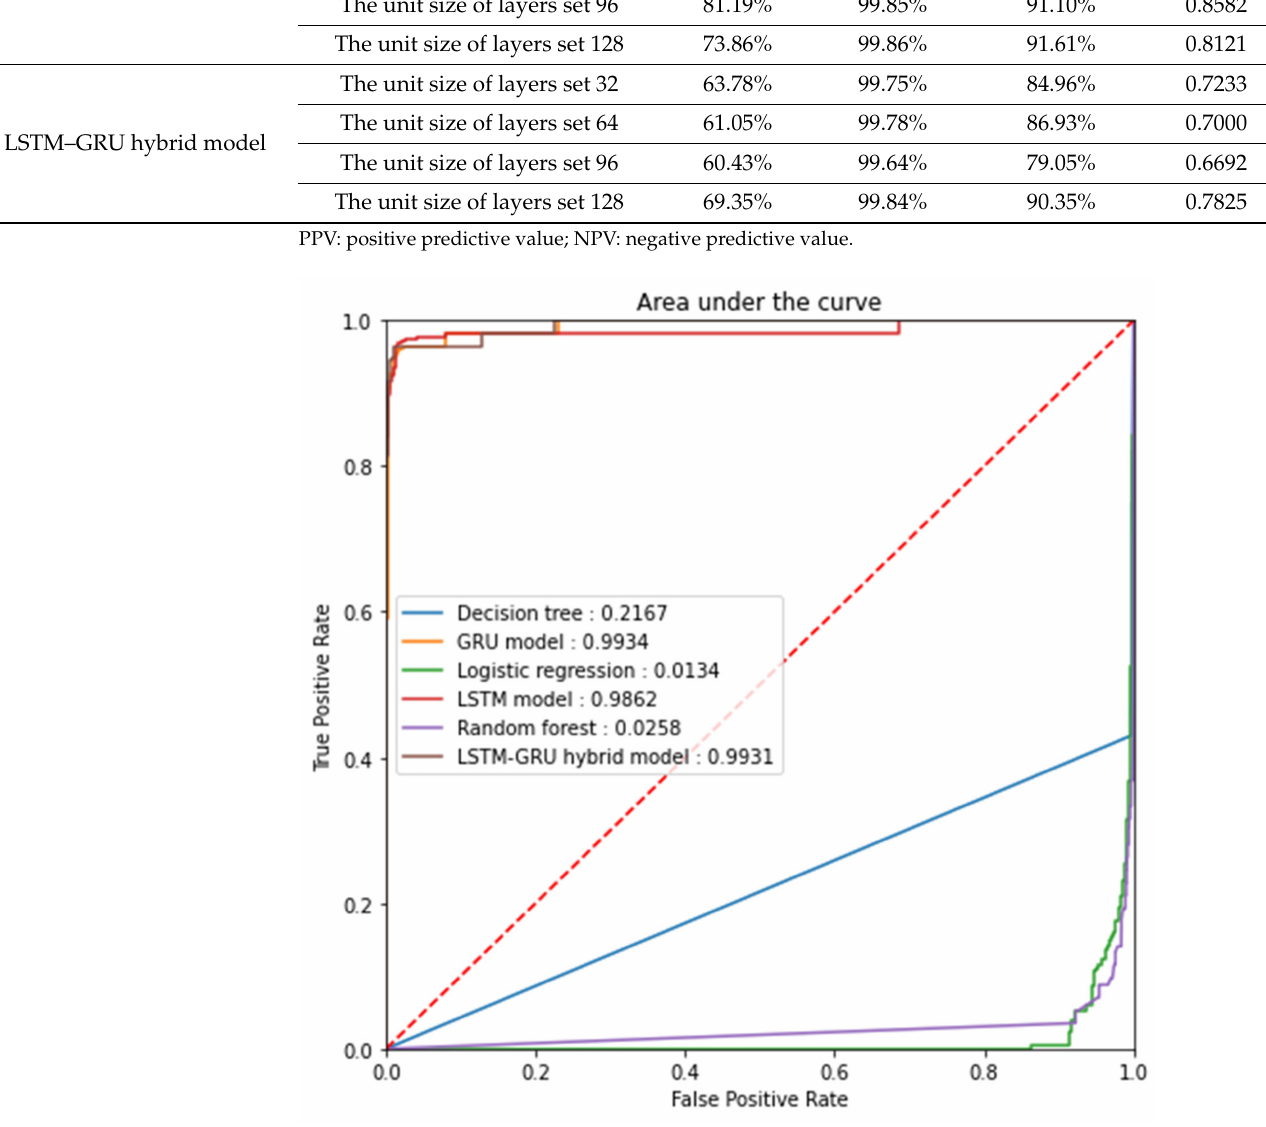
Figure 5. Receiver operating characteristic (ROC) curve of each